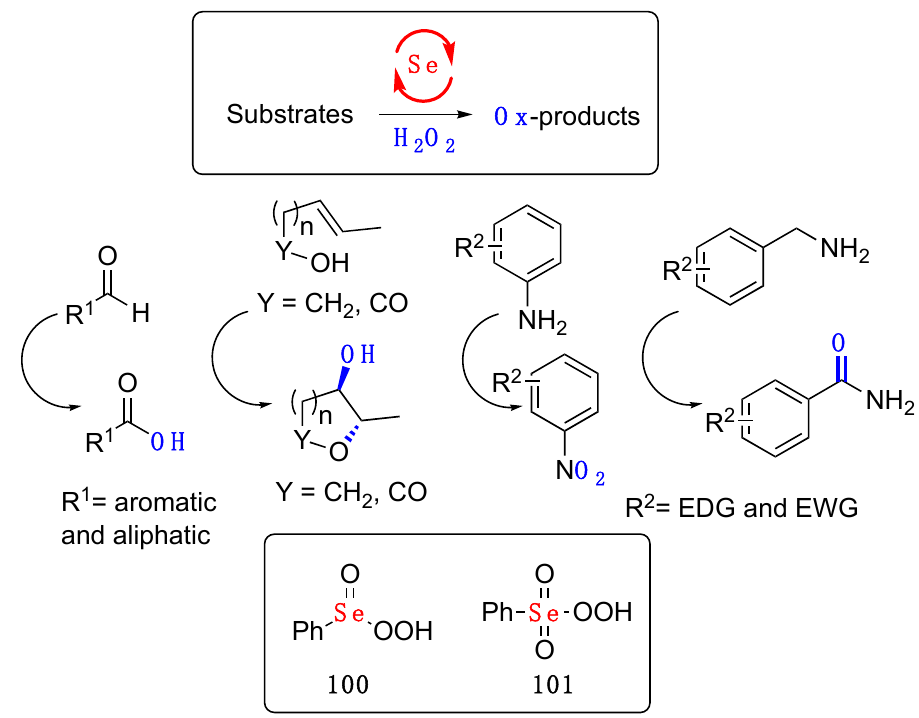
Figure 2. Se ‐ catalyzed bioinspired oxidative transformations. Figure 2. Se-catalyzed bioinspired oxidative